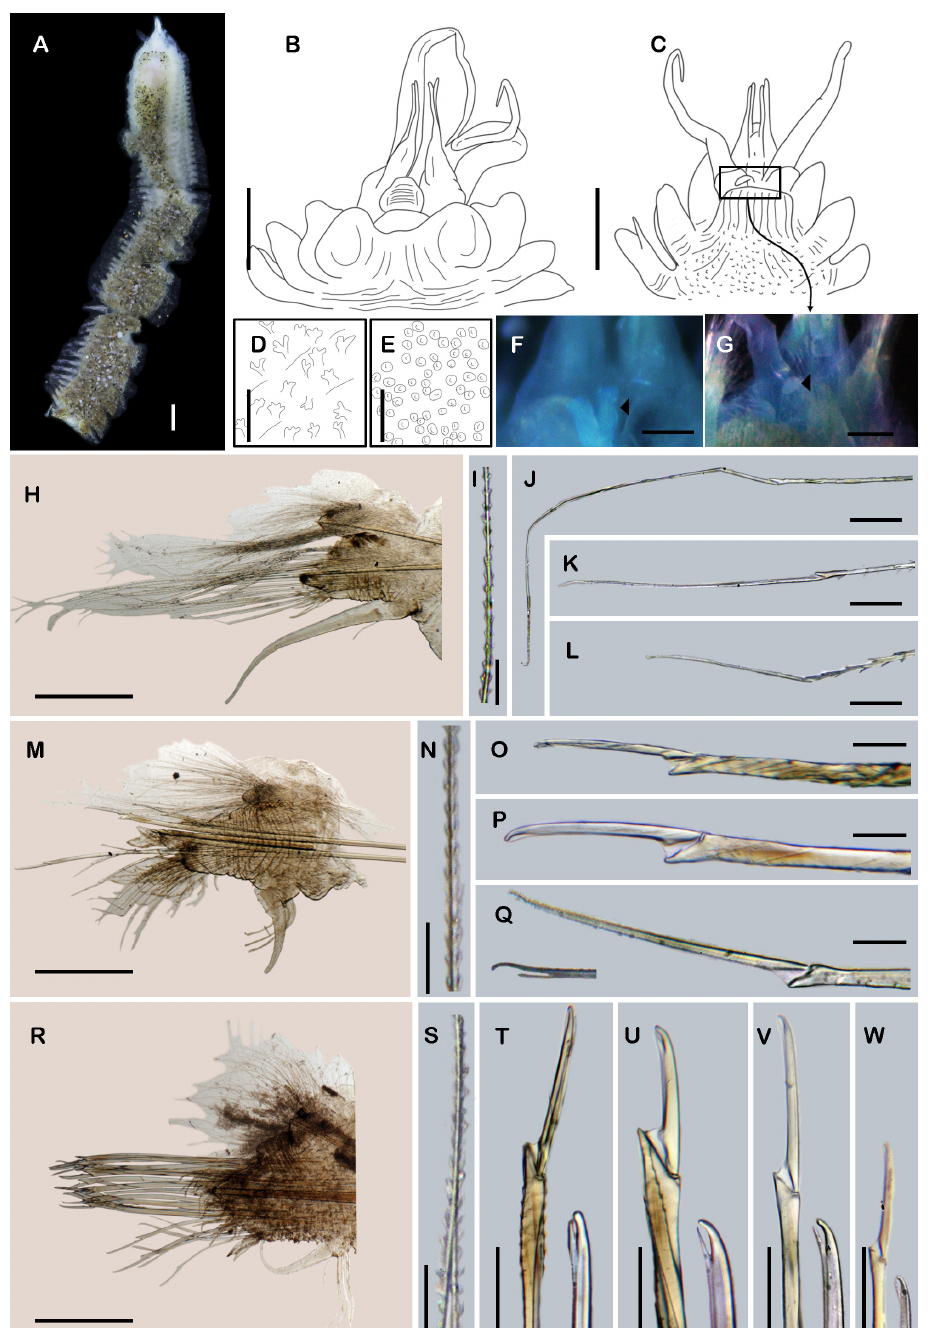
Fig. 11. Neopsammolyce aff. floccifera (Augener, 1906), non-type material (UMML 6607-393). A . Incomplete worm, dorsal view. B . Anterior end, dorsal view. C . Anterior end, ventral view. D . Dorsal papillae (close-up in box). E . Ventral papillae (close-up in box). F . Close-up of B, arrowhead indicates lateral antennae (median antenna displaced). G . Close-up of C, arrowhead indicates facial tubercle. H . Right parapodium from segment II. I . Notochaeta from same. J . Unit A. K . Unit B. L . Units C and D. M . Right parapodium from segment III. N . Notochaeta from same. O . Unit A. P . Unit B. Q . Units C and D. R . Right parapodium from segment 61. S . Notochaeta from same. T . Unit A. U . Unit B. V . Unit C. W . Unit D. Scale bars: A = 2 mm; B–C = 1 mm; D–E = 50 µm; F–G = 200 μm; H, M, R = 500 μm; I, N, S = 40 μm; J–L, O–Q, T–W = 50